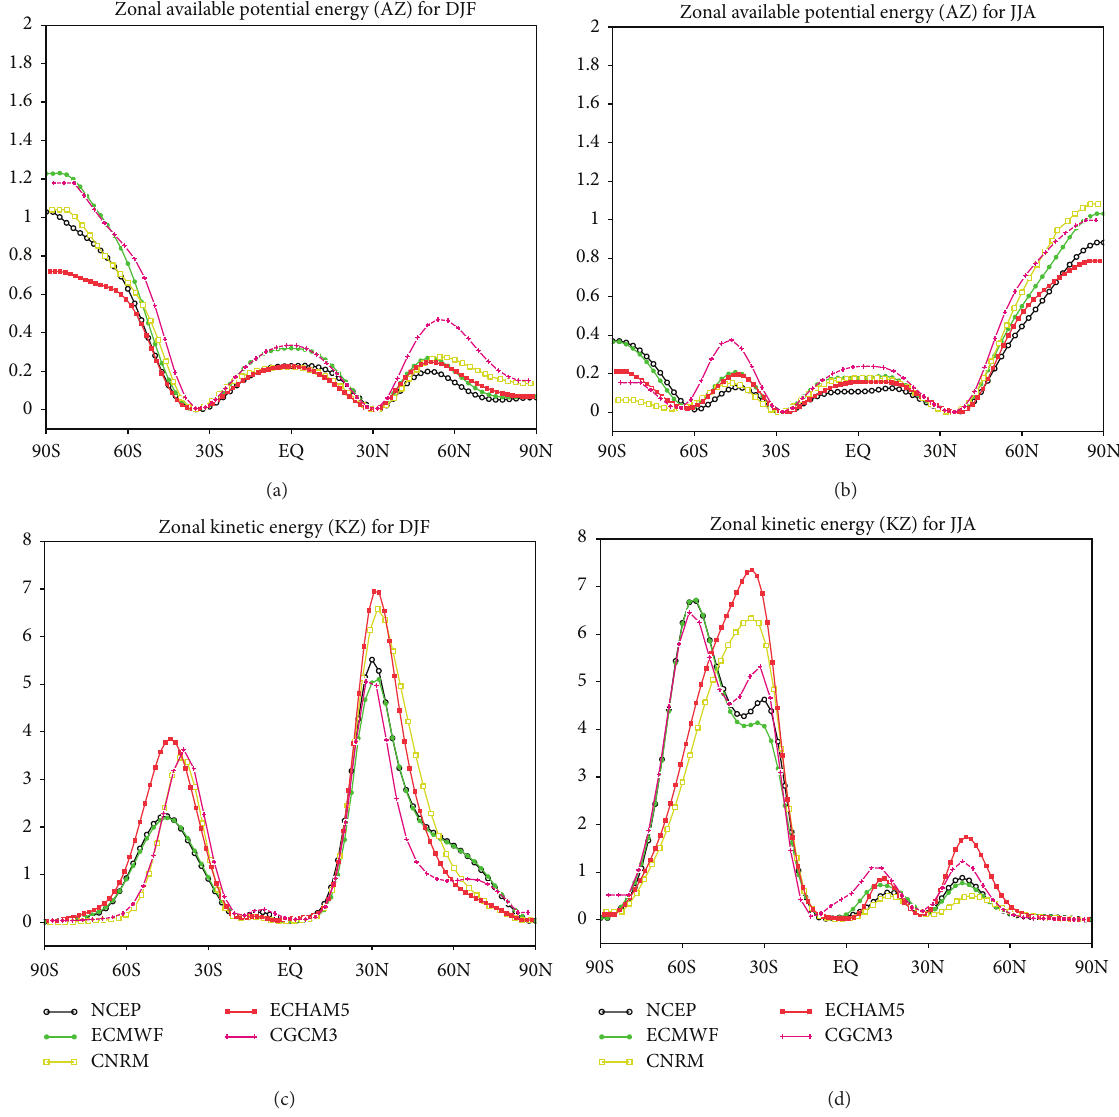
Figure 3: Latitudinal distribution of volume integrated zonal available potential energy for DJF (a) and JJA (b) and zonal kinetic energy for DJF (c) and JJA (d) for the period from 1979 to 1999. Units are 10 5 Jm −2